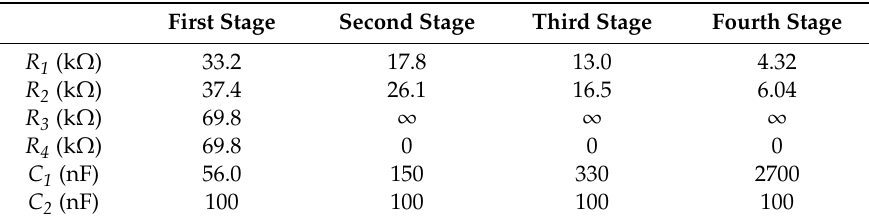
Table 1. Components of the line-frequency low-pass filter in Figure